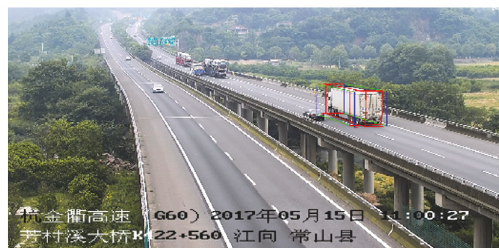
Figure 32: Location of the back-projection plane of the front and left views of truck.